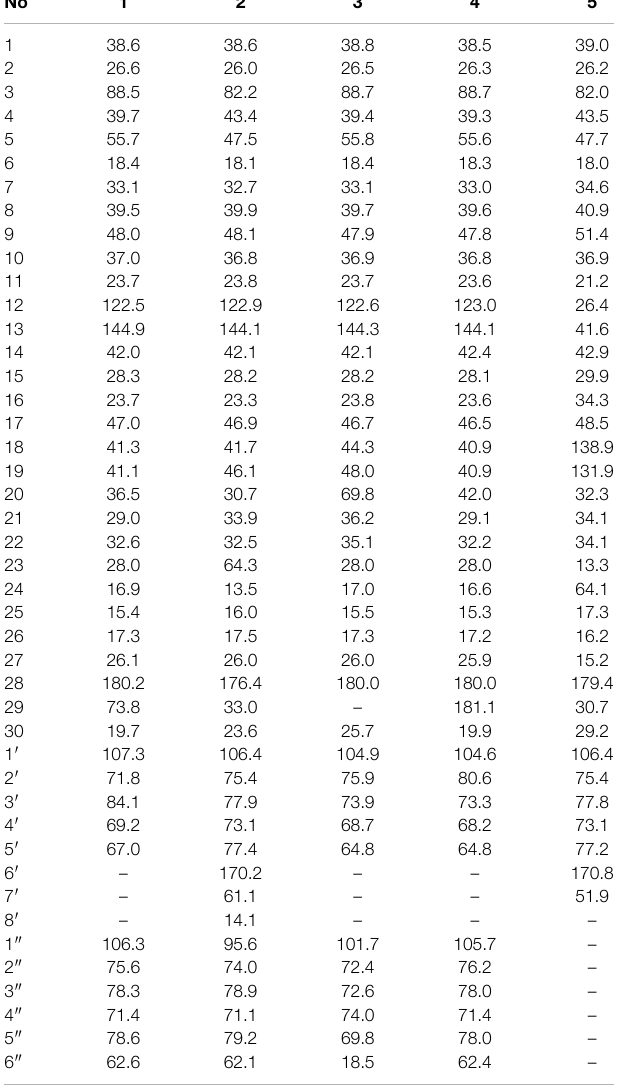
TABLE 1 | 13 C NMR data ( δ ) for compounds 1 – 5 (150, MHz in pyridine- d